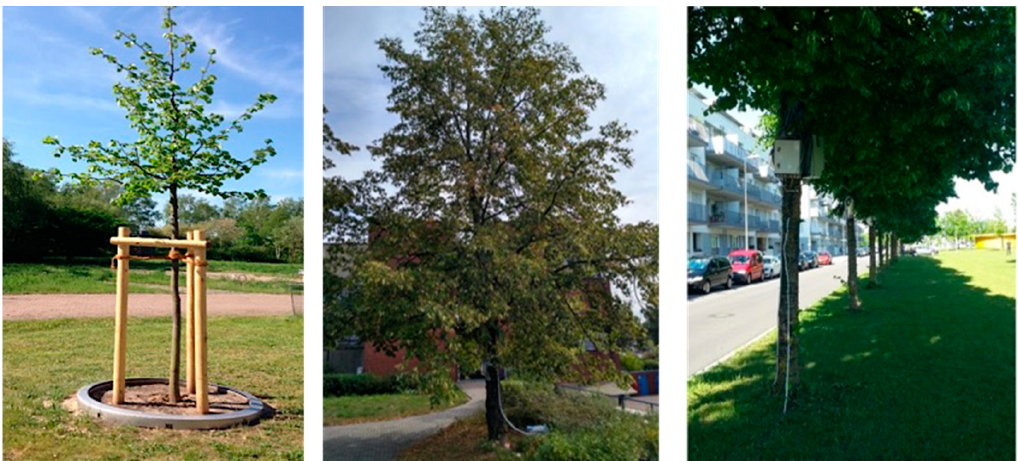
Figure 8. Three Linden trees ( Tilia cordata ) used for sap-flow measurements. Left: Young (in 2017) planted tree growing in a steel lysimeter in the center of an experimental station of the UBA in Berlin-Marienfelde. Middle: 30–40-year-old tree growing in a park-like situation not far away. Right: 35-year-old street tree that was used in 2017 for the sap-flow measurements by Rahman et al. [57].